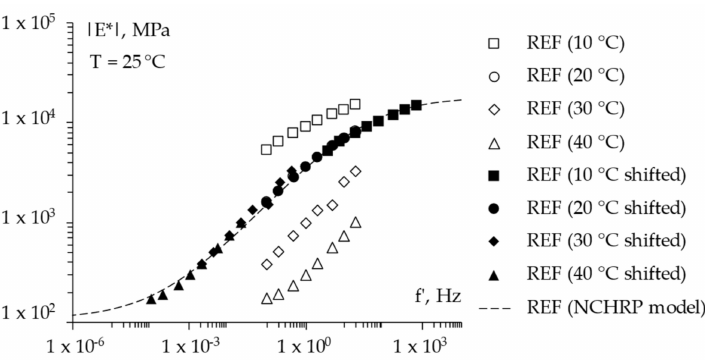
Figure 8. The frequency sweep results (master curve) of the REF mixture.